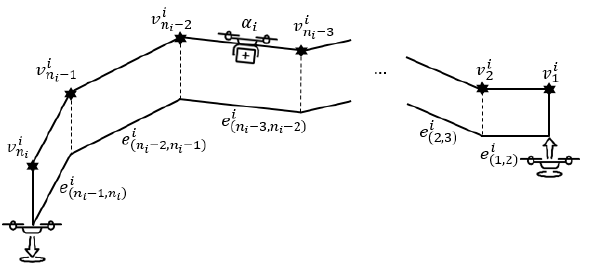
Figure 2. A series of linear segments (sUAS α i ’s flight route from its origin v i